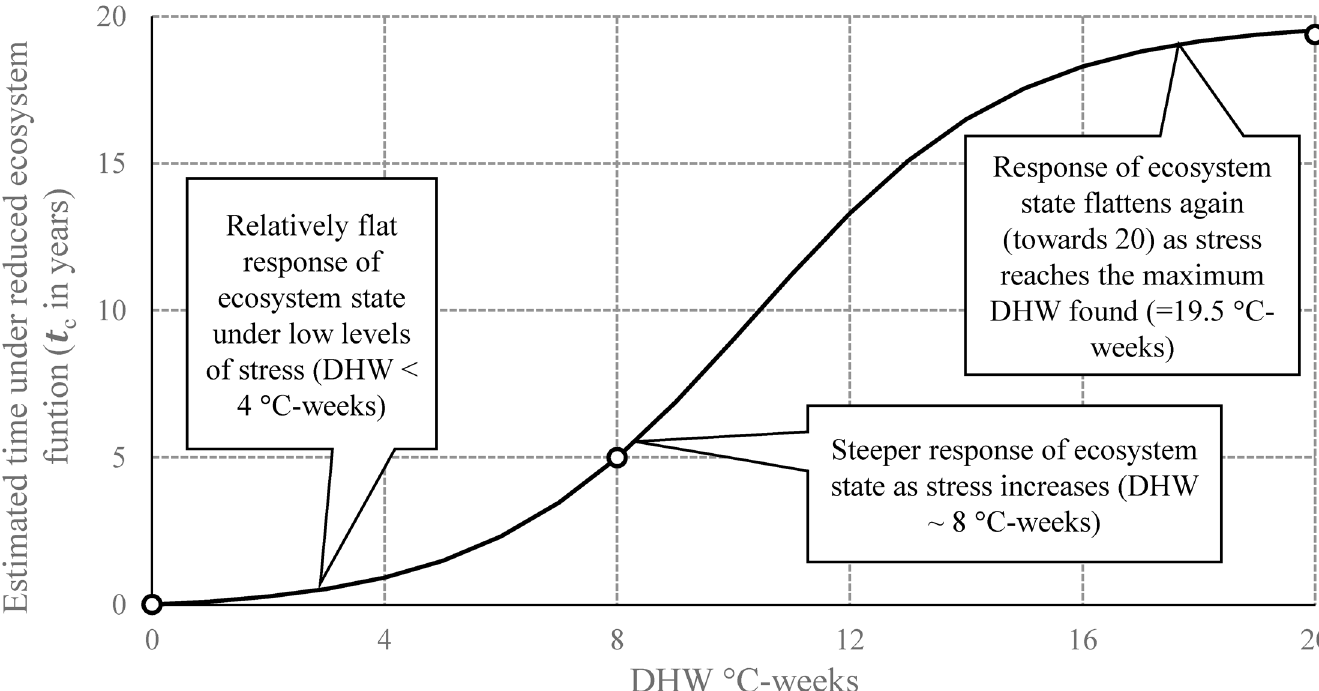
Fig 3. Conceptual illustration of the effects of acute thermal stress on coral-reef ecosystem state described by a logistic function. Empty circles indicate values used to fit the model. The form of this function assumes that the time that coral reefs spend with reduced ecosystem function (capacity to grow, repair, and reproduce), t c , is short at low DHW values because we expect that corals would recover quickly (within one year). This is followed by a steeper increase in t c ; when widespread mortality begins (DHW reaches 8°C-weeks), the time that corals would spend recovering increases rapidly as bleaching-level events intensify above this level. When almost the entire community is extirpated over large spatial scales (above about 16°C-weeks), we expect to have small increments of t c with increasing DHW for the ecosystem as a whole because only stress-tolerant species that can withstand greater acute disturbance are present. The function then reaches an upper bound (i.e., in the formulae — asymptotic value — equal to 20 years) which is the maximum time required to regenerate a fully functional ecosystem after bleaching causes massive mortality and extirpates all organisms.